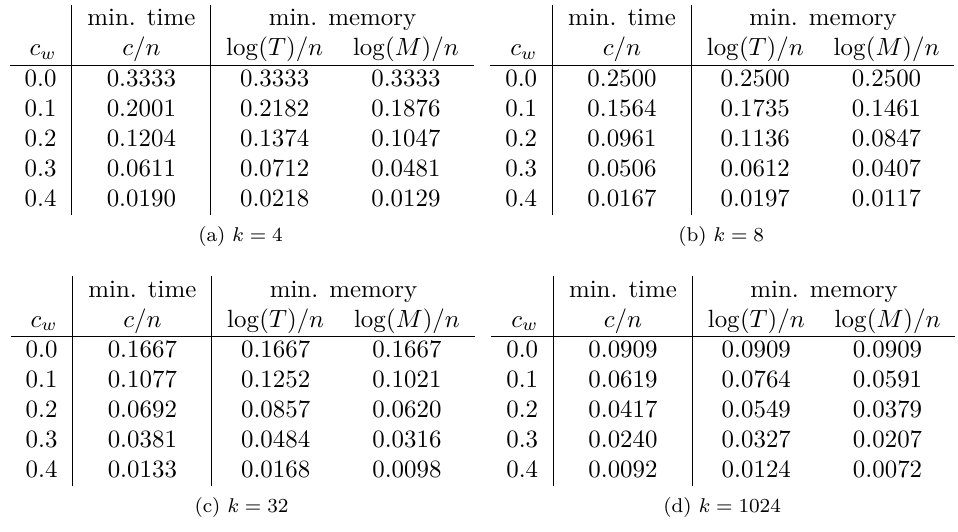
Figure 9: Comparisons of the run-time exponents log( T ) nents log( M ) between the time-minimized ( c 6 = ‘ , T = M = 2 c ) and memory-minimized n ( c = ‘ , M = 2 c , T = T 2 ) choice of